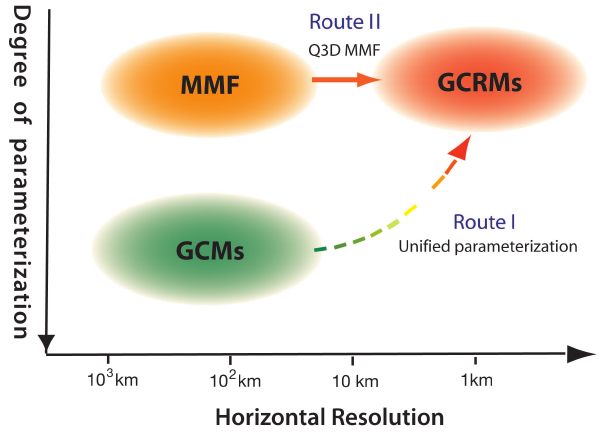
Fig. 15. Two routes to unify coarse- and fine-resolution